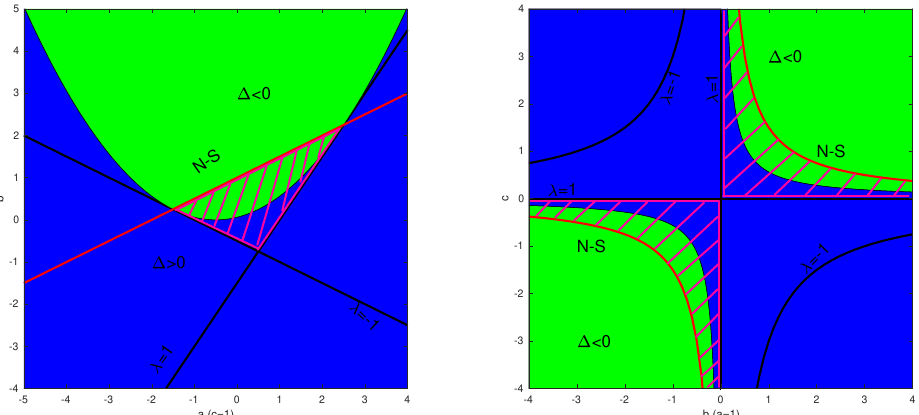
Figure 3. In ( a ) on the left hand side the bifurcation conditions together with the asymptotic stability region of the map in Equation (17) are represented in the plane ( a , b ) with c = 1; In ( b ) on the right- hand side the bifurcation conditions together with the asymptotic stability region are represented in the plane ( b , c ) with a = 1. In green the area in which eigenvalues are complex, in blue where eigenvalues are real, the black lines denote the flip and fold bifurcations, the red line marks the Neimarck Sacker bifurcation, and the striped area characterizes the asymptotic stability region. The Figure can be compared with Figure 1 to see that the presence of market makers enlarge the stability